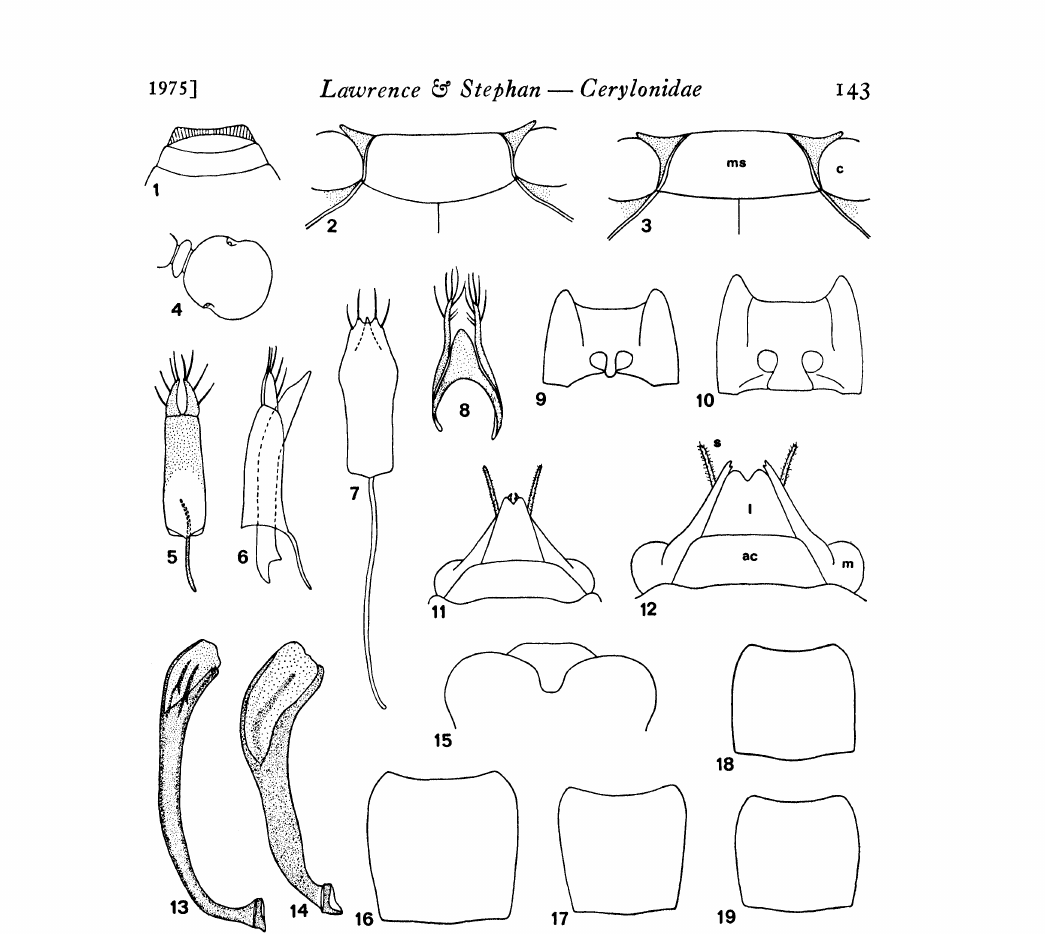
Fig. 1. Cerylon unicolor (Ziegler), fifth ventrite, posteroventral view. lig. 2. Mychocerus delressus LeConte, mesosternum and portion of meta- sternum. Fig. 3. Mychocerus arizonensis, n. sp., same (ms mesosternum; c _---z coxa). Fig. 4. Ostomolsis neotroicalis, n. sp., antennal club. Fig. 5. Mychocerus arizonensis, tegmen, dorsal view. F’ig. 6. M. arizonensis, aedeagus, lateral view. Fig. 7. Ostomoksis neotropicalis, tegmen, dorsal view. Fig. 8. Philothermus occidentalis, n. sp., tegmen, dorsal view. Fig. 9. P. occidentalis, prothorax, ventral view. Fig. 10. Cerylon unicolor (Ziegler), prothorax, ventral view. Fig. 11. Lalethus striatus (Sen Gupta and Crowson), anterior portion of head, dorsal view. Fig. 12. Lalethus discretus Casey, same (ac anteclypeus, labrum, m man-